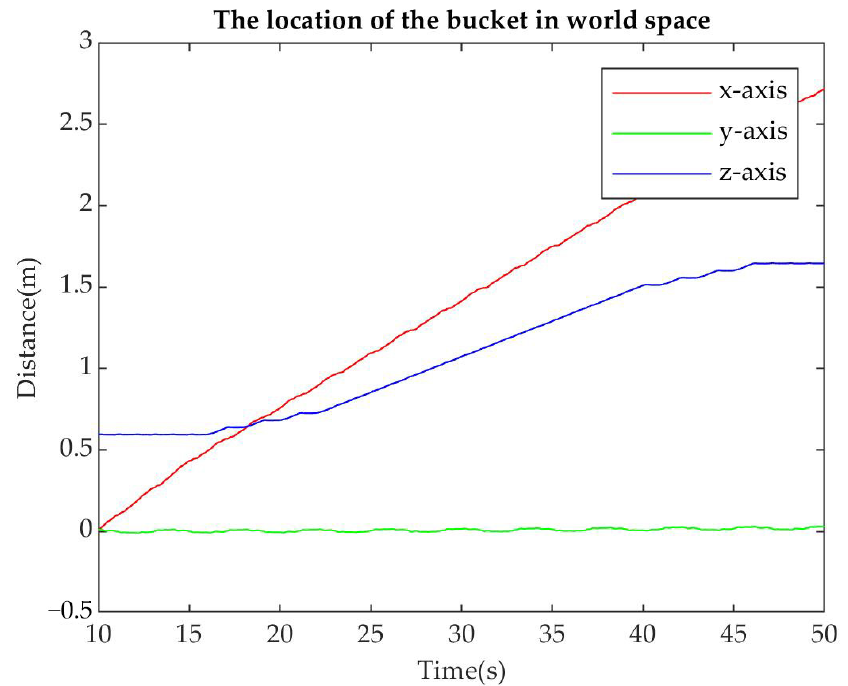
Figure 25. Bucket position changes between 10 and 50 s. The bucket has periodic small movements in the y direction, nearly uniform linear movement in the x direction, and smooth movement in the z direction.